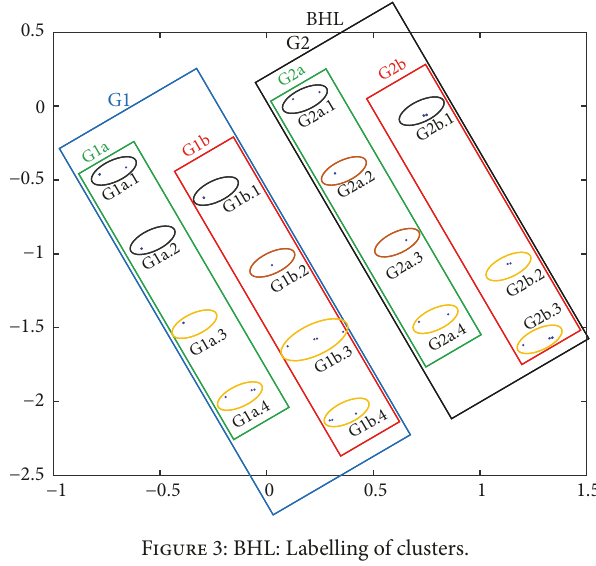
Figure 3: BHL: Labelling of clusters.